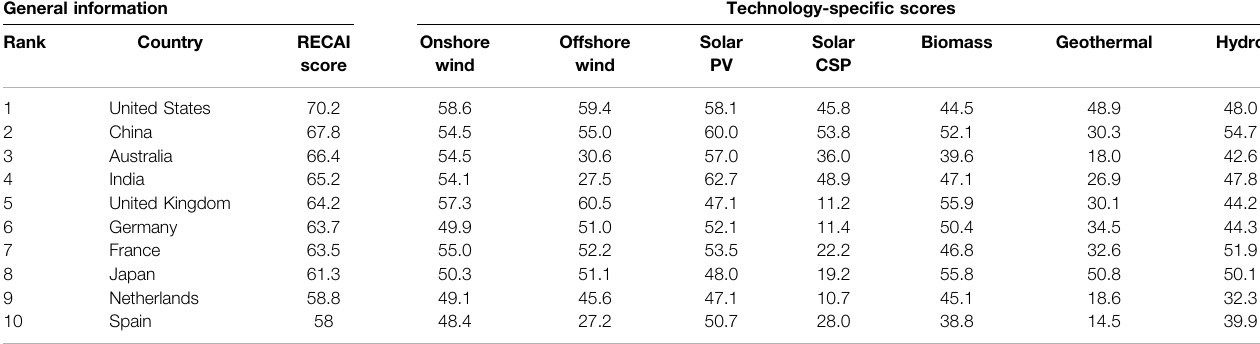
TABLE 1 | Top 10 countries that invest in renewable sources. General